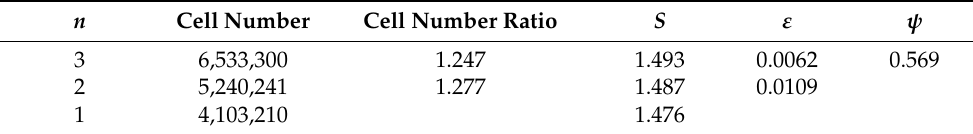
Table 3. Mesh independence analysis for the duct